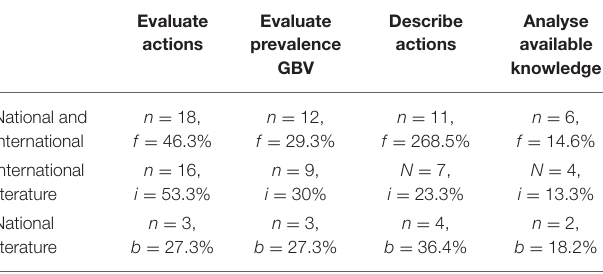
TABLE 2 | Objectives of the papers. TABLE 3 | School scope of